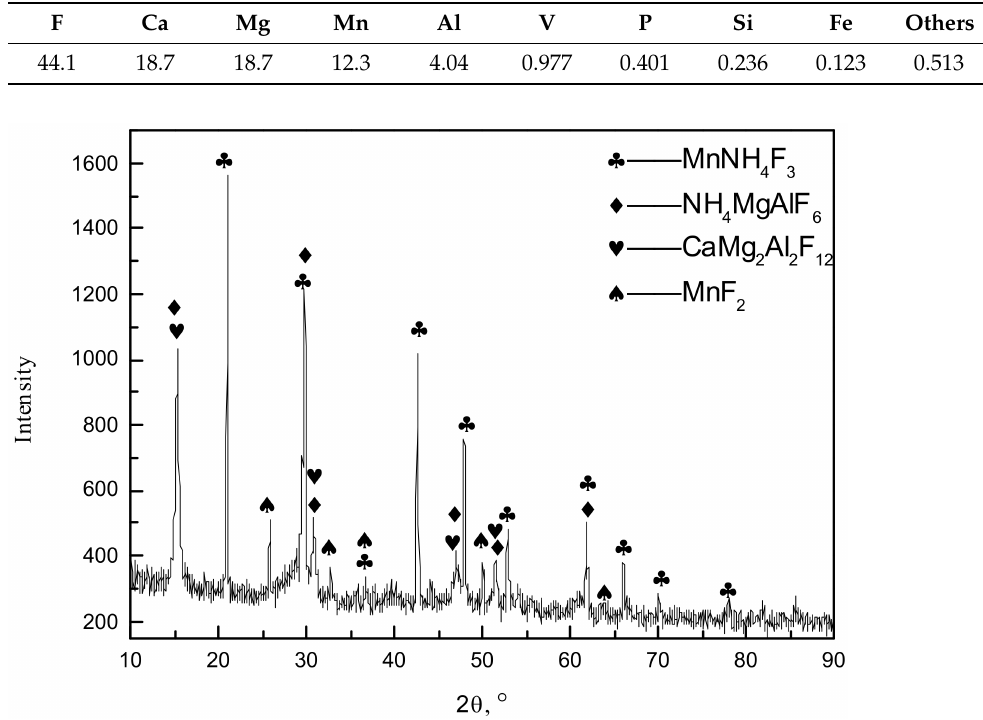
Table 5. X-ray fluorescence (XRF) analysis for the precipitate obtained during the purification with MnNH 4 F 3 (wt. %).